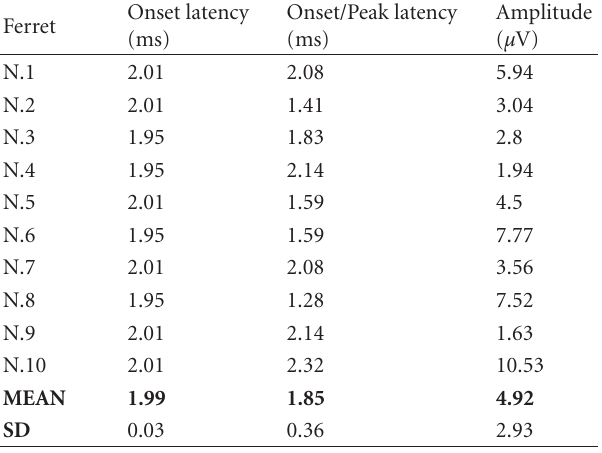
Table 3: Values of cord dorsum potential (CDP) of tibial nerve stimulated at the tarsus and recorded at